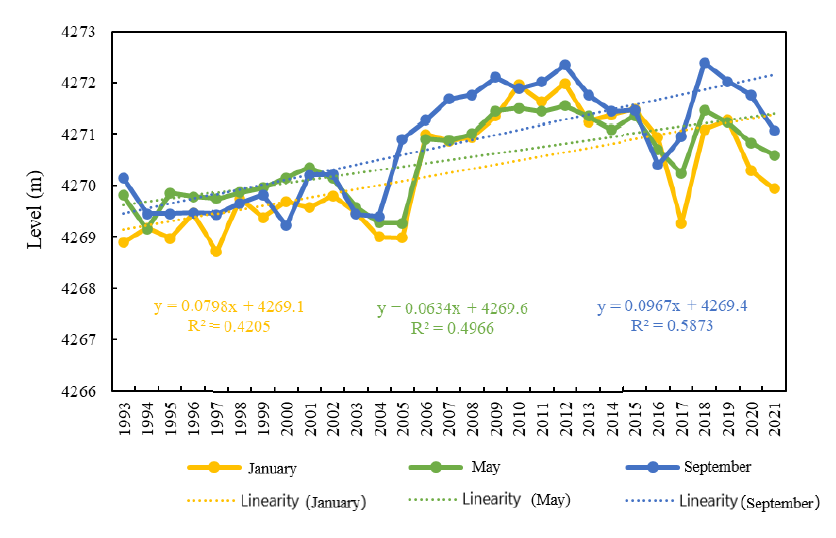
Figure 8. The monthly average water level of Ngoring Lake during glacial, melting, and nonglacial periods during the period